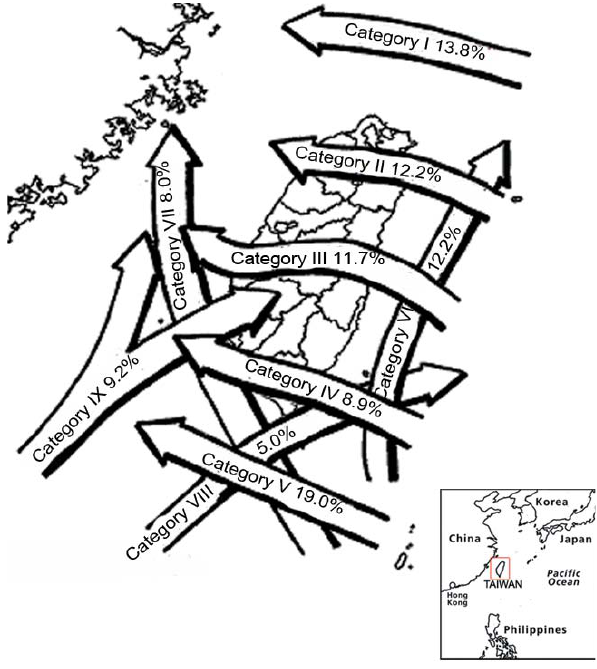
Figure 1 Category of tracks of typhoons attack Taiwan Fig. 1. Category of tracks of typhoons attack